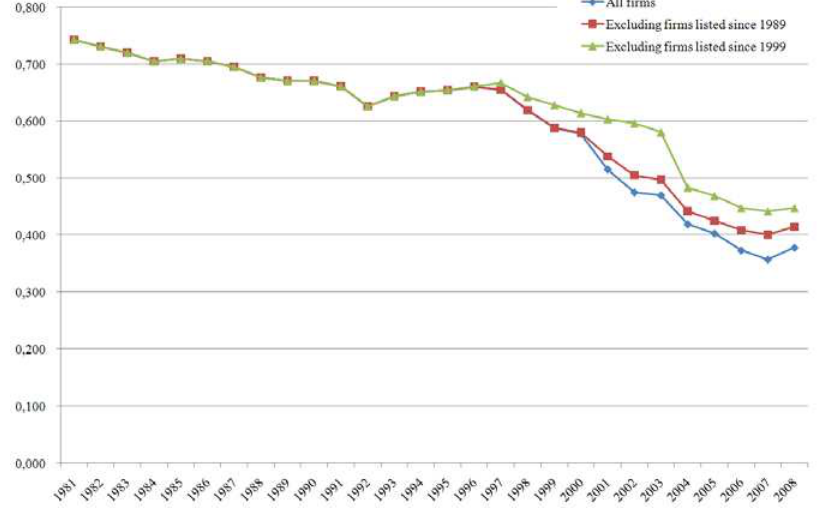
Fig. 2. Net leverage ratio